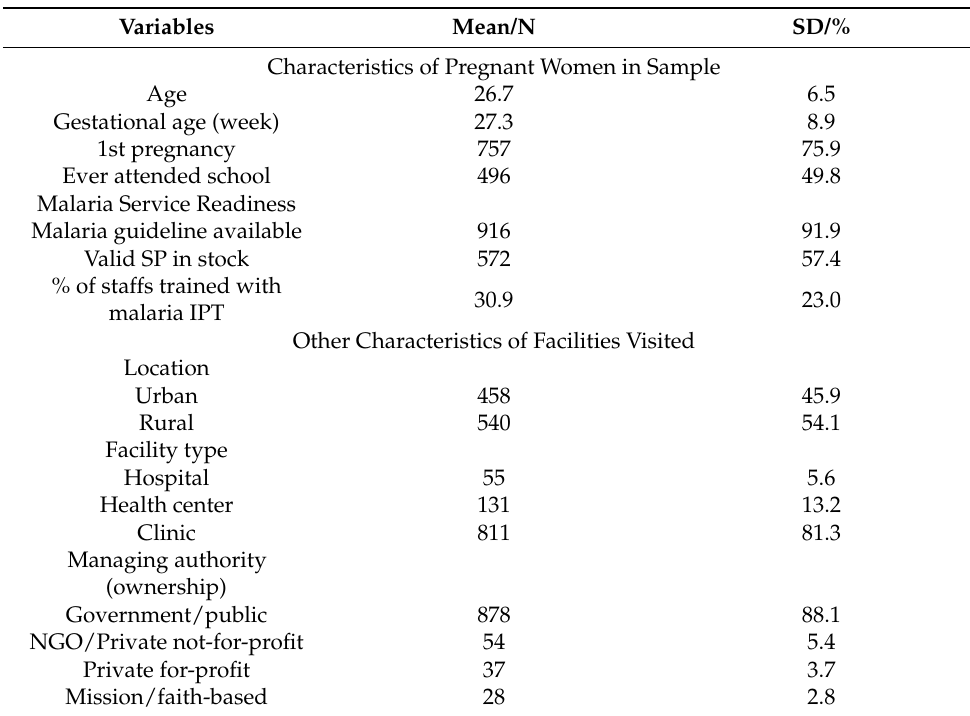
Table 1. Summary Statistics of Pregnant Women (weighted N =